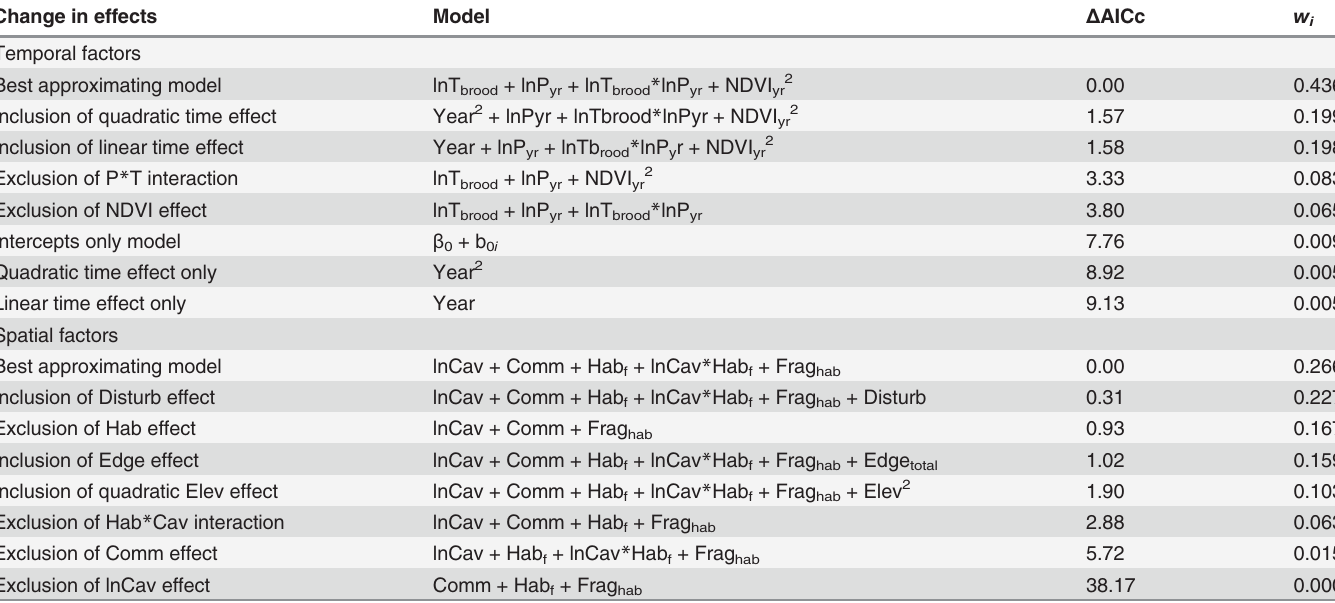
Table 4. Rankings of best approximating models of the effects of temporal and spatial factors on reproductive output of ferruginous pygmy- owls in northwest Mexico, 2001 – 2010 compared to other models where some effects were included, excluded, or